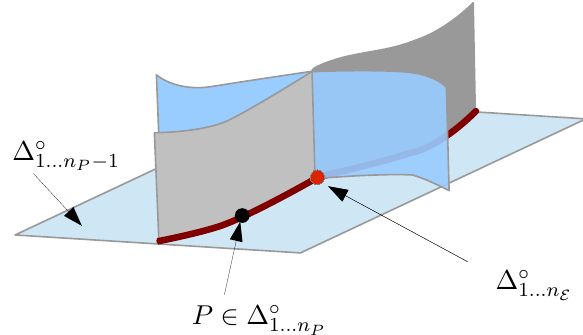
Figure 10 . Illustration of the general setup showing a patch E around a point P which lies on the intersection of n P singular divisors, but away from any further intersections P 2 (cid:1) (cid:14) the patch, there is also a further enhancement due to an intersection of additional divisors at (cid:1) (cid:14)